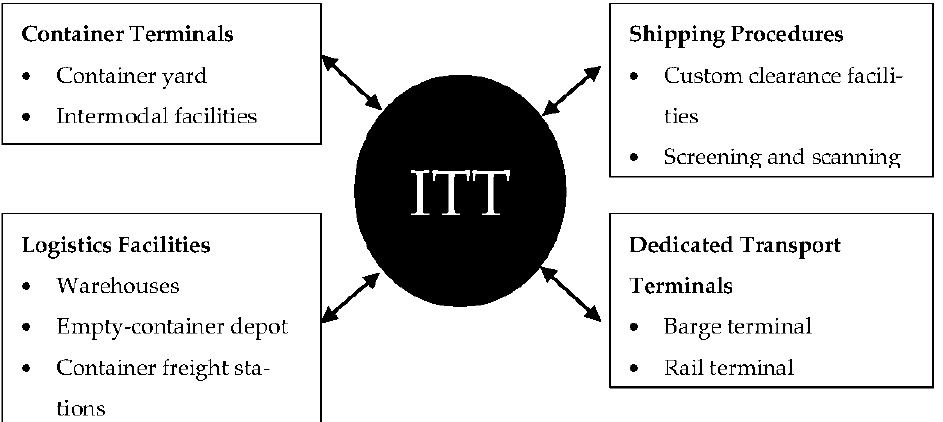
Figure 1. Role of ITT at seaports (adapted from [2]).